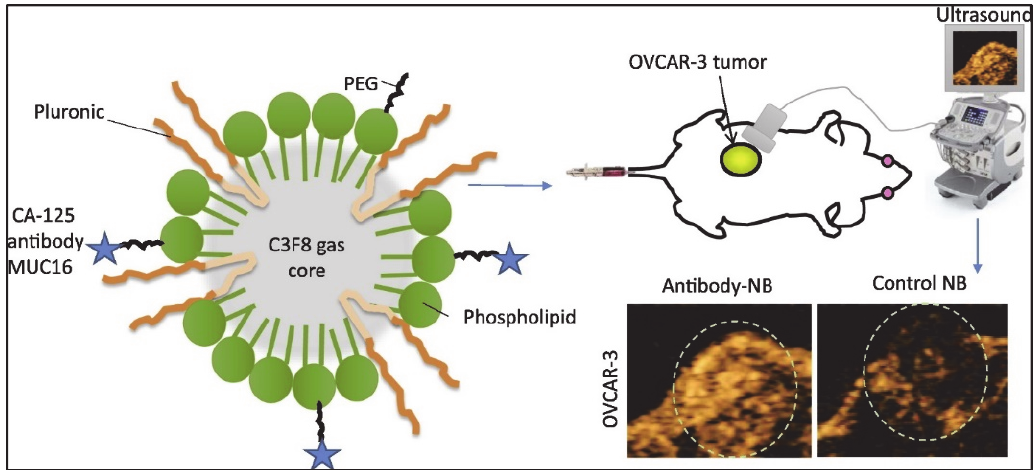
Figure 9 Ultrasound contrast agents able to target a molecular signature on the surface of cancer cells could be a promising strategy for improved cancer detection. The diagram demonstrates application of CA-125-targeted echogenic lipid and surfactant-stabilized nanobubbles (smaller than 200 nm mean hydrodynamic diameter) for targeting CA-125 positive OVCAR-3 tumors in mice. Targeted or non-targeted nanobubbles were injected into mice (via tail vein) bearing either CA-125 positive or negative flank ovarian tumors. Tumors were imaged with contrast harmonic imaging at 12 MHz, and time–intensity curves and histology were utilized to compare tumor distribution and pharmacokinetics of the contrast agents. (Reprinted with permission from reference [37])